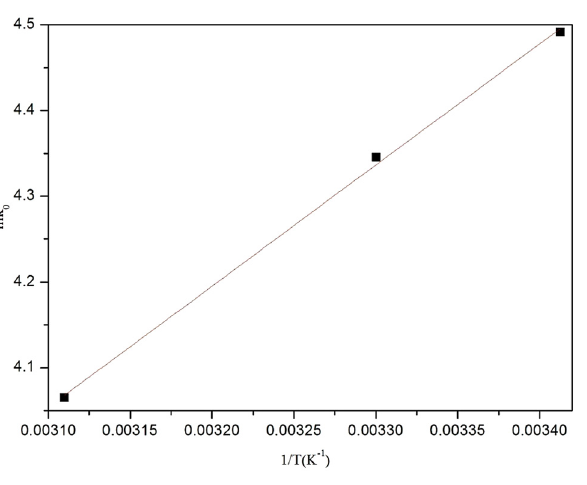
Figure 7: The thermodynamic equilibrium of CR adsorption by Sm -